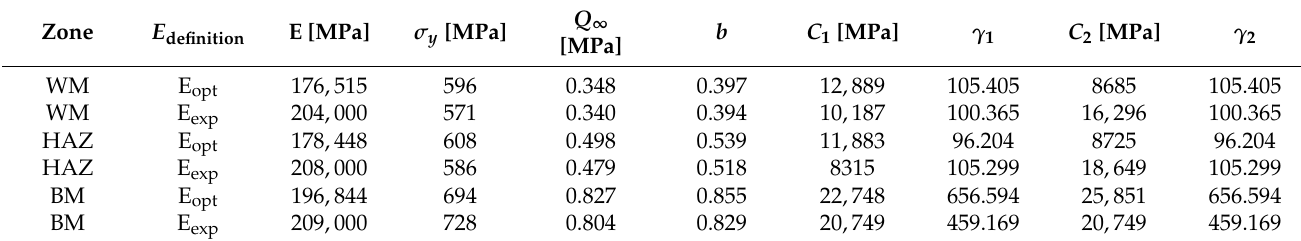
Table 4. Summary of the V–C model parameters. The elastic modulus E opt is a result of the V–C model parameter optimization. The elastic modulus E exp is determined based on the material response. The Poisson’s ratio ν = 0.3 is used in each parameter set. The remaining parameters are the yield stress σ y , the isotropic differential stress at saturation Q ∞ , the isotropic saturation rate parameter b , the kinematic stress parameter for the 1st and the 2nd backstress C 1 and C 2 , and the corresponding kinematic saturation rate parameter γ 1 and γ 2